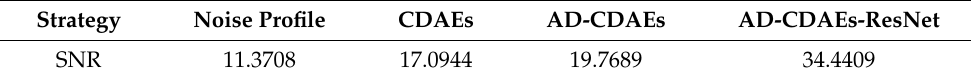
Table 4. SNR comparison.